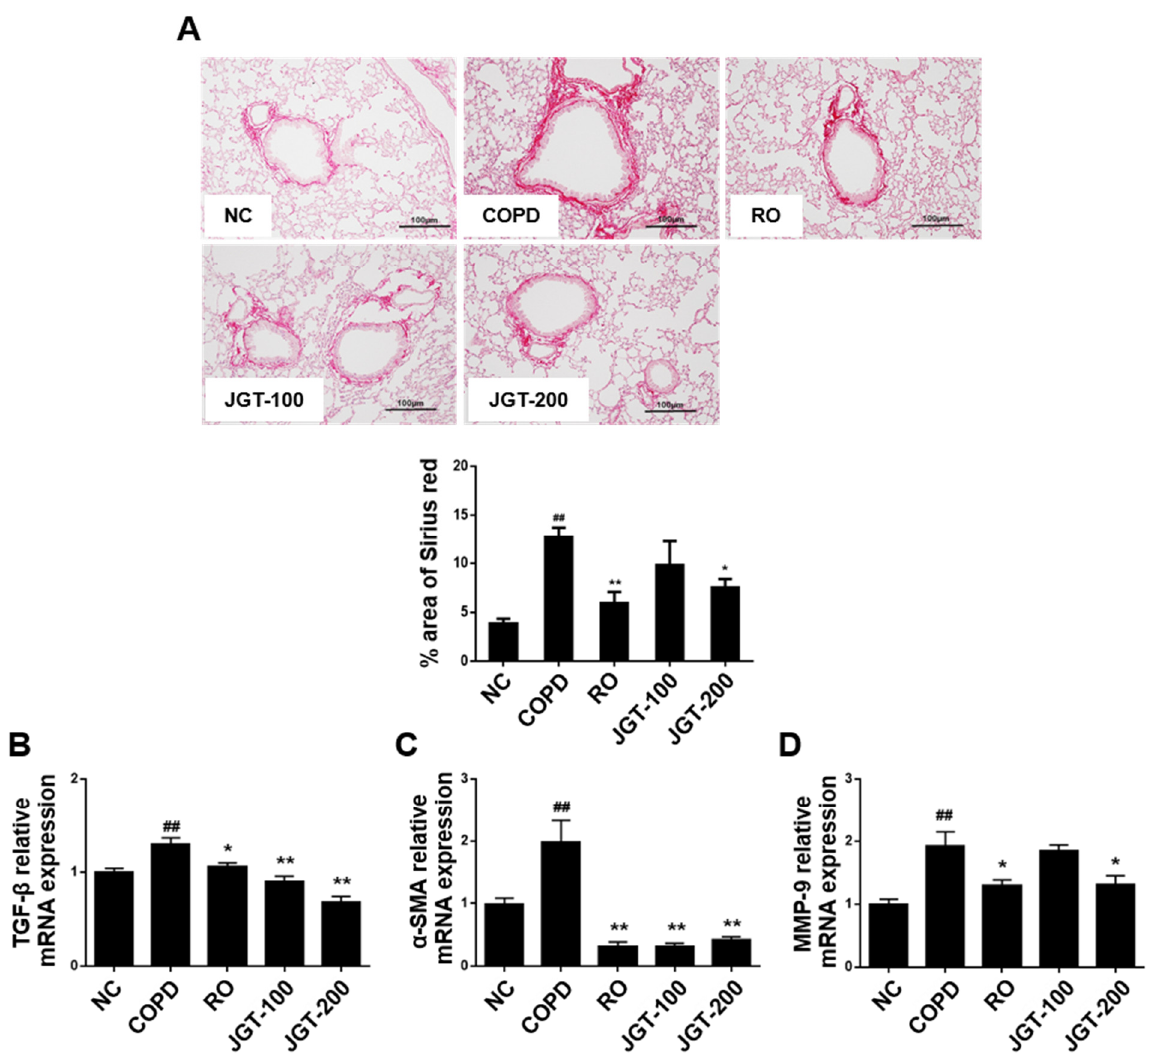
Figure 7. Effects of JGT on ( A ) the collagen deposition and the levels of ( B ) TGF- β , ( C ) α -SMA, and ( D ) MMP-9 mRNAs, as measured by RT-PCR. NC, normal control mice; COPD, CS & LPS-treated mice; RO, roflumilast (5 mg/kg) along with CS & LPS-treated mice; JGT-100, JGT (100 mg/kg) along with CS & LPS-treated mice; JGT-200, JGT (200 mg/kg) along with CS & LPS-treated mice. Data are displayed as means ± SEM. ## p < 0.01 compared with NC; * p < 0.05 and ** p < 0.01 compared with COPD.